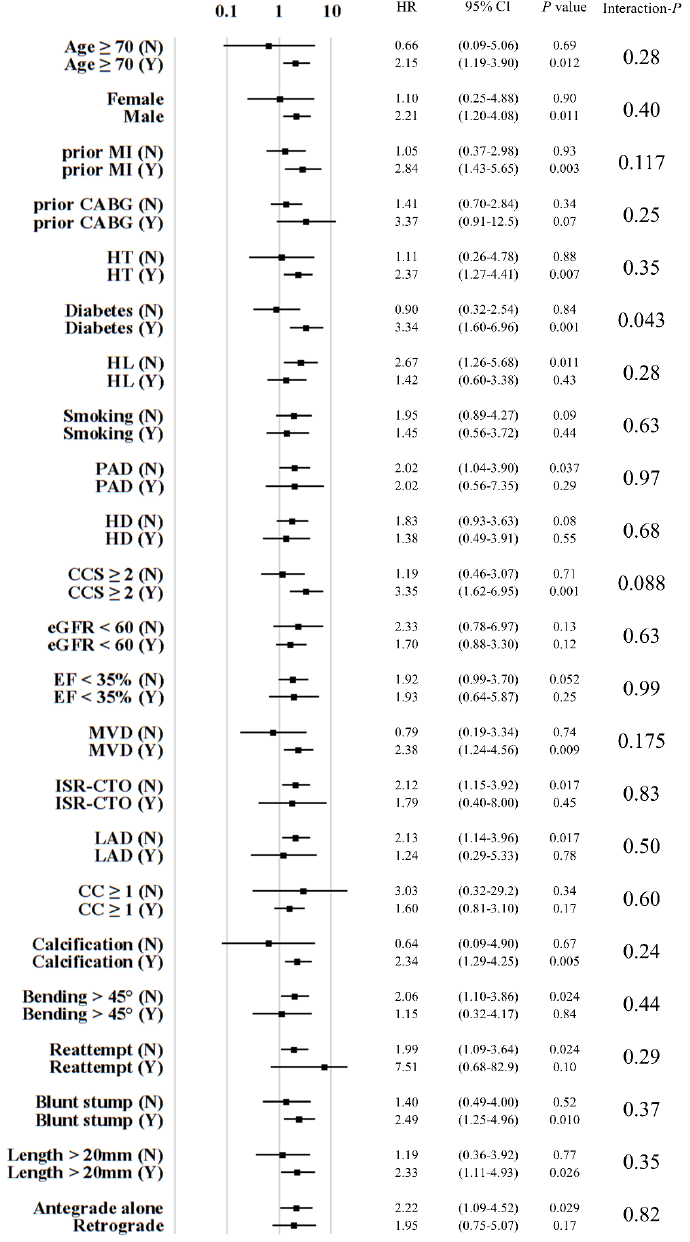
Figure 1. Stratified analysis of hazard ratios for procedural results of CTO-PCI and one-year mortality.